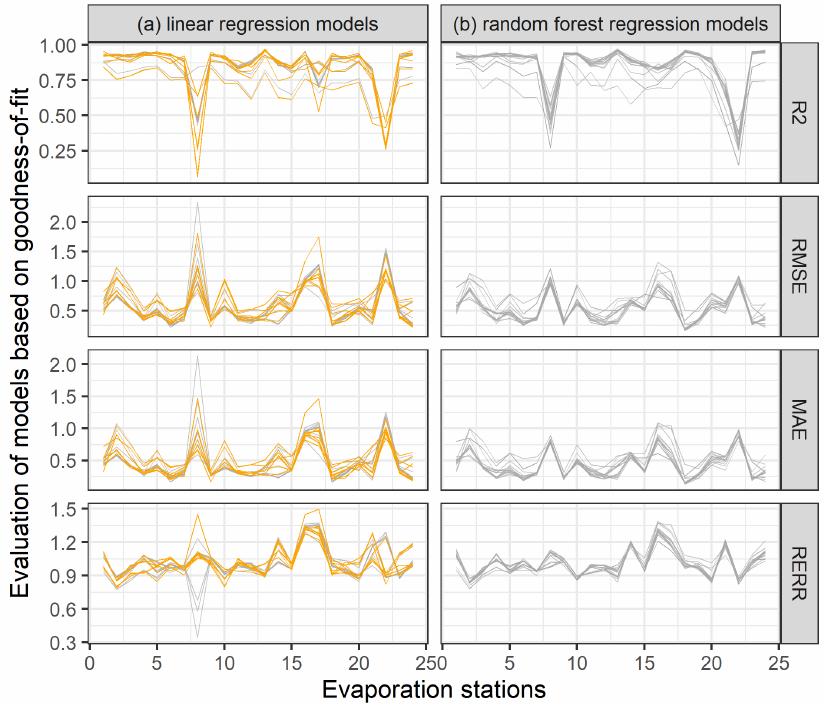
Figure 3. Model evaluation using GOF (R 2 , RMSE, MAE, RERR). The lines in the plot represent the LM and RFM models. Part ( a ) linear regression models (18 models) is divided into two parts: orange line: models created manually (8 models), grey part: stepwise regression was used (10 models). Part ( b ) random forest regression models (15 models).